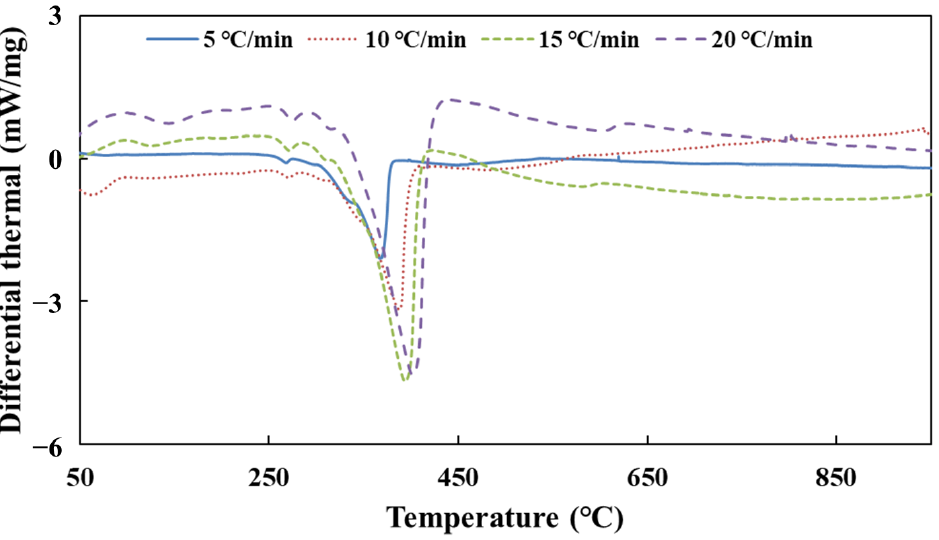
Figure 5. The DSC curves of CYA pyrolysis at different heating rates. According to the DSC curves of CYA pyrolysis, the peak temperature data T p is obtained at different heating rates. Table 8 shows the result of the activation energy of CYA decomposition by substituting these data into Equation (32). Finally, the activation energy of CYA decomposition is 150 kJ/mol (95% confidence interval, CI: 109–190, as shown in Figure A8) calculated from the Kissinger method. Table 8. The activation energy E K of CYA decomposition (Unit: kJ/mol).